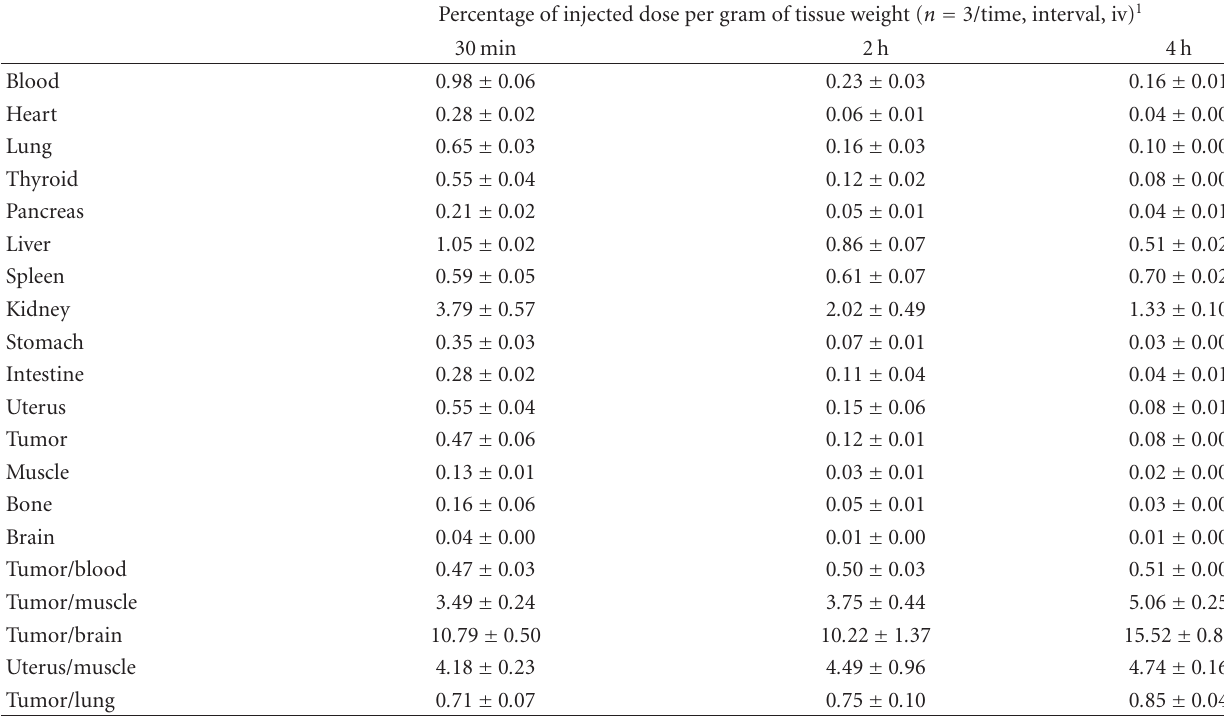
Table 2: Biodistribution of 99m Tc-ECG in mesothelioma-bearing rats.